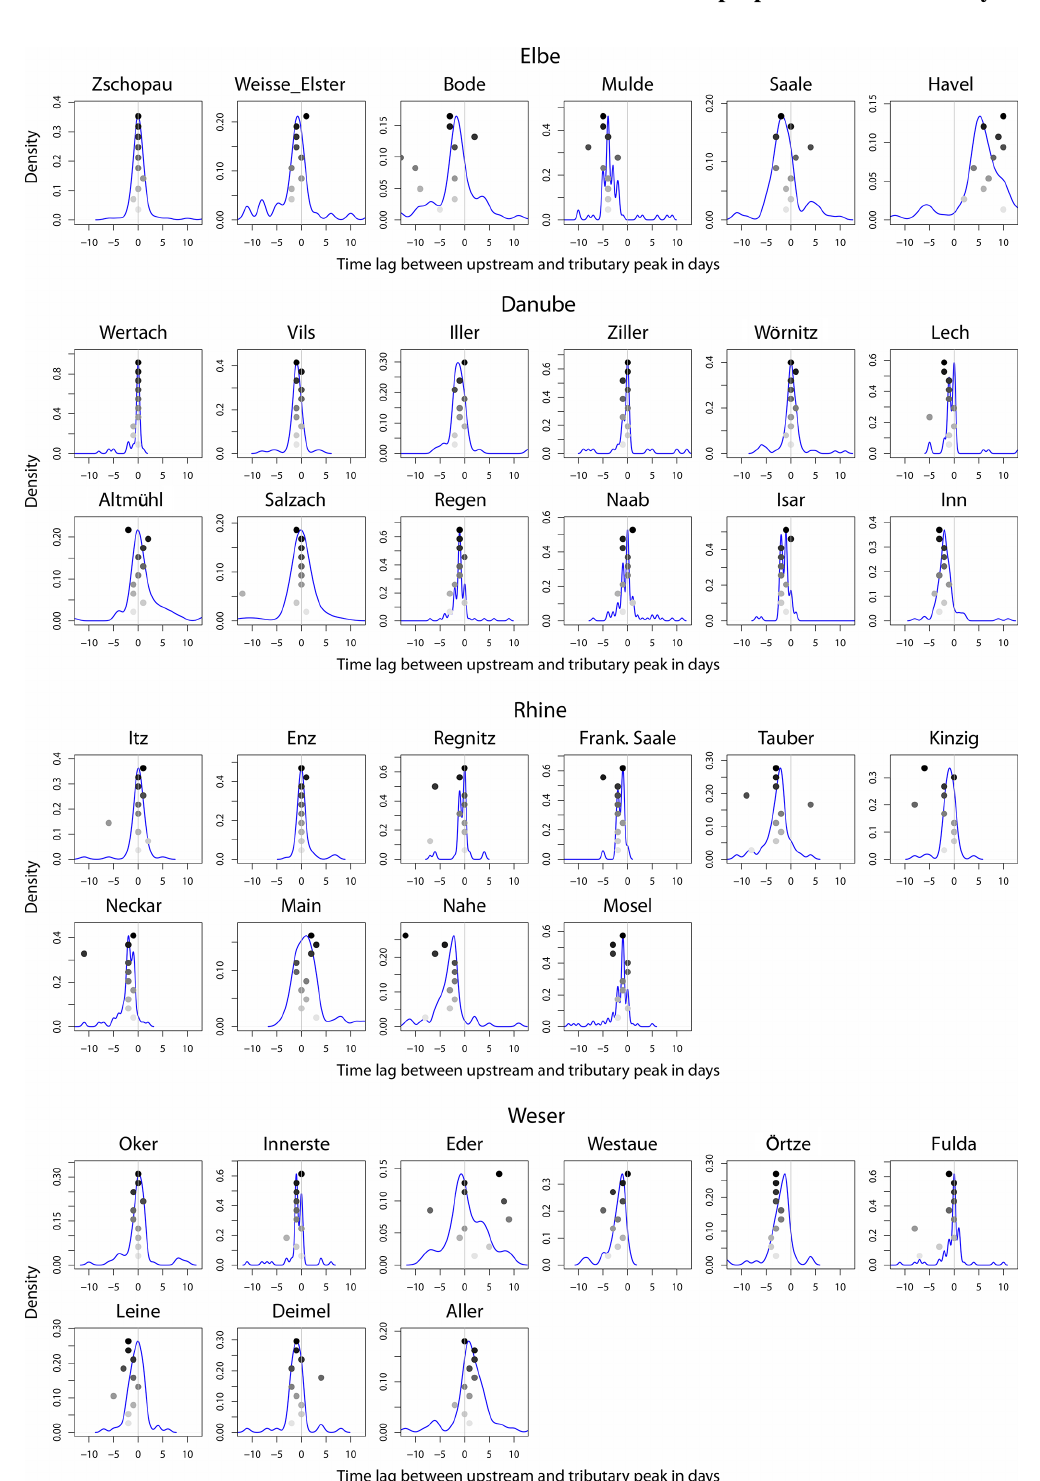
Figure 5. Density of the time lag in days between the tributary and upstream peak. A positive time lag means that the tributary peak occurs later. The 10 largest events are shown as circles with decreasing grey colour intensity. The catchments are ordered by increasing catchment size in each